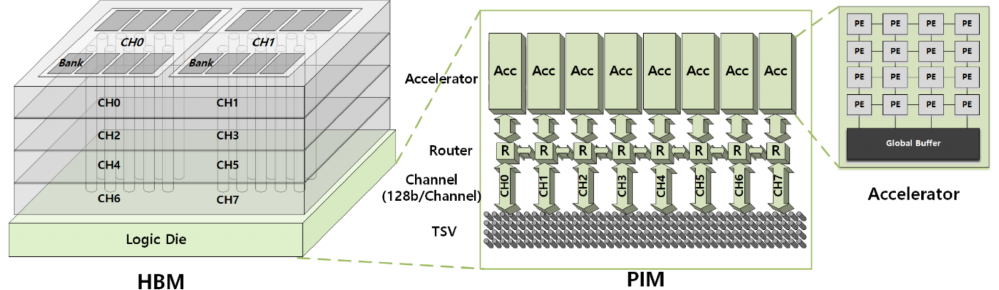
Figure 6. The block diagram of accelerator and HBM2 assumed in this